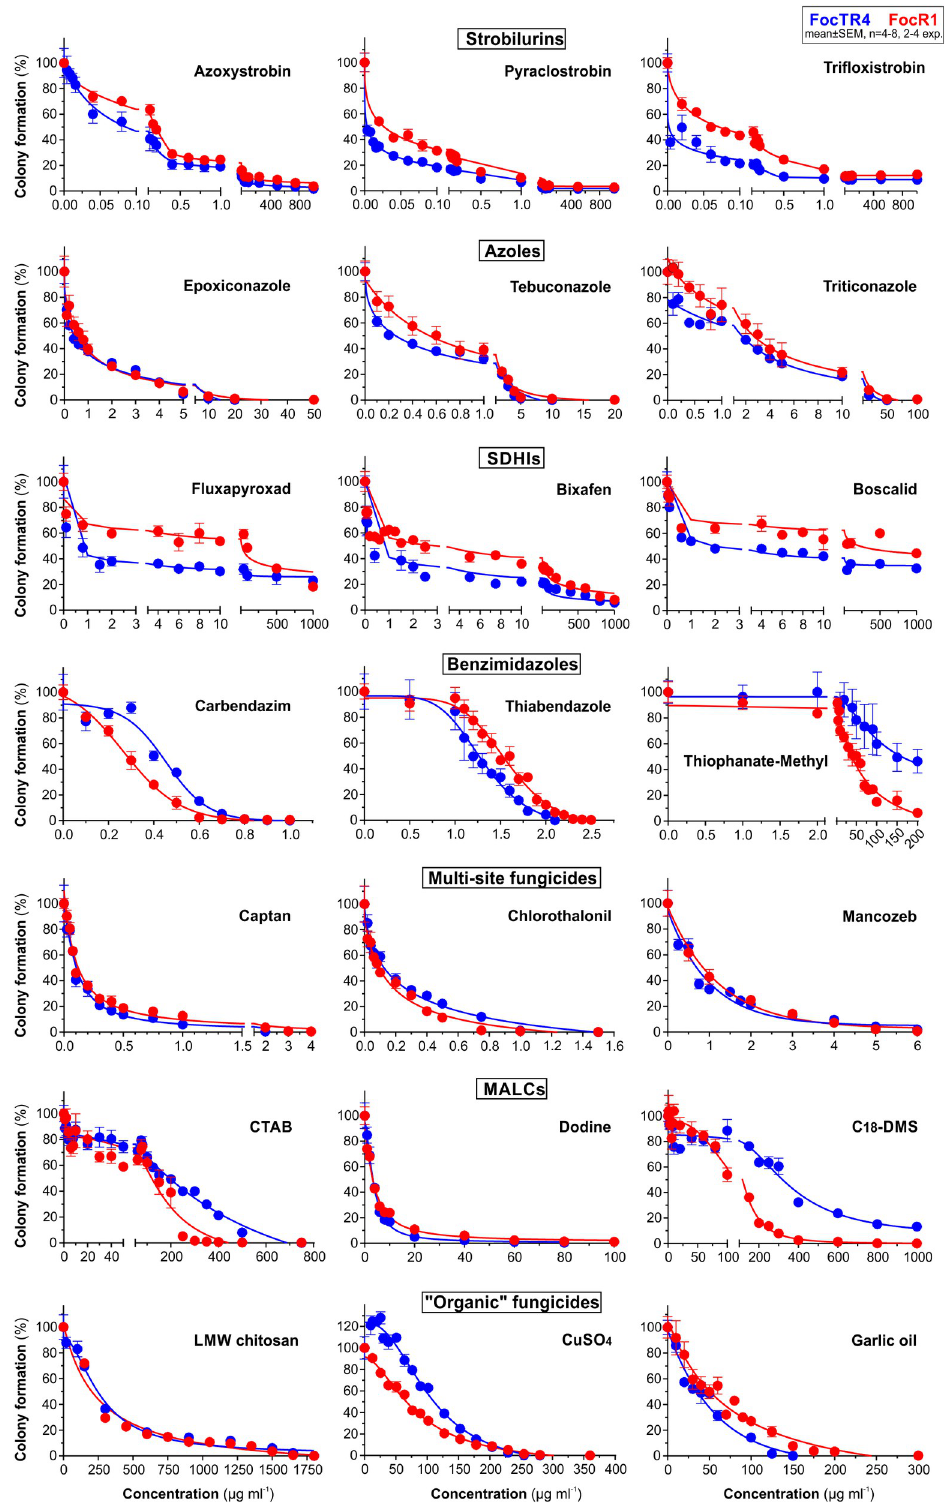
Fig 3. Quantitative assessment of colony formation of FocR1 and FocTR4 on PDA plates, supplemented with fungicides. Growth was monitored by measuring cell formation in images (see Methods) after 2d incubation at